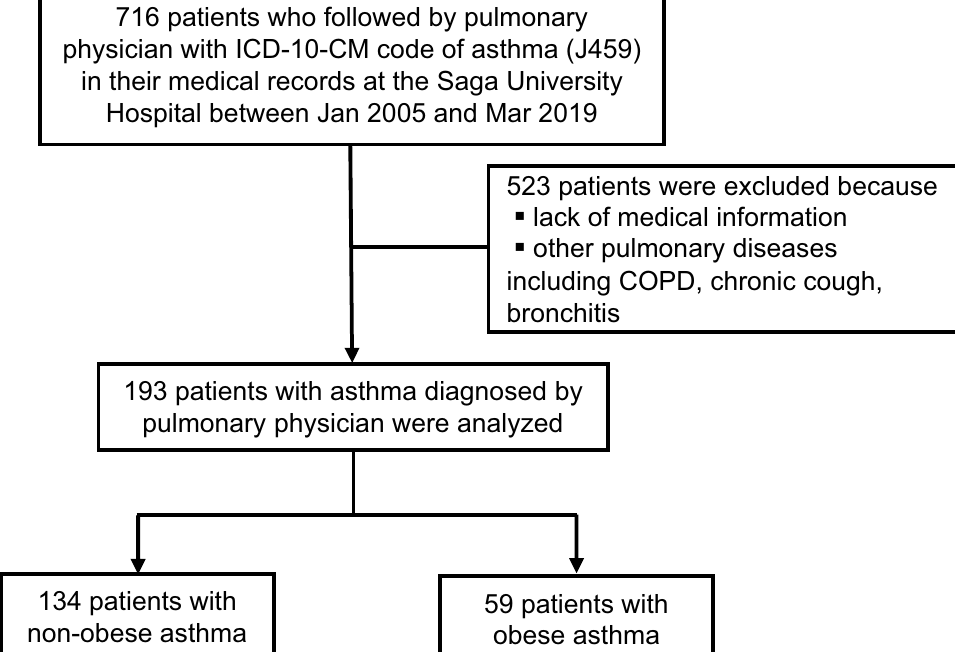
Figure 1. Study design: Patients with asthma. A total of 193 patients with asthma diagnosed by a pulmonary physician were identified, and 134 non-obese patients with asthma and 59 obese patients with asthma were